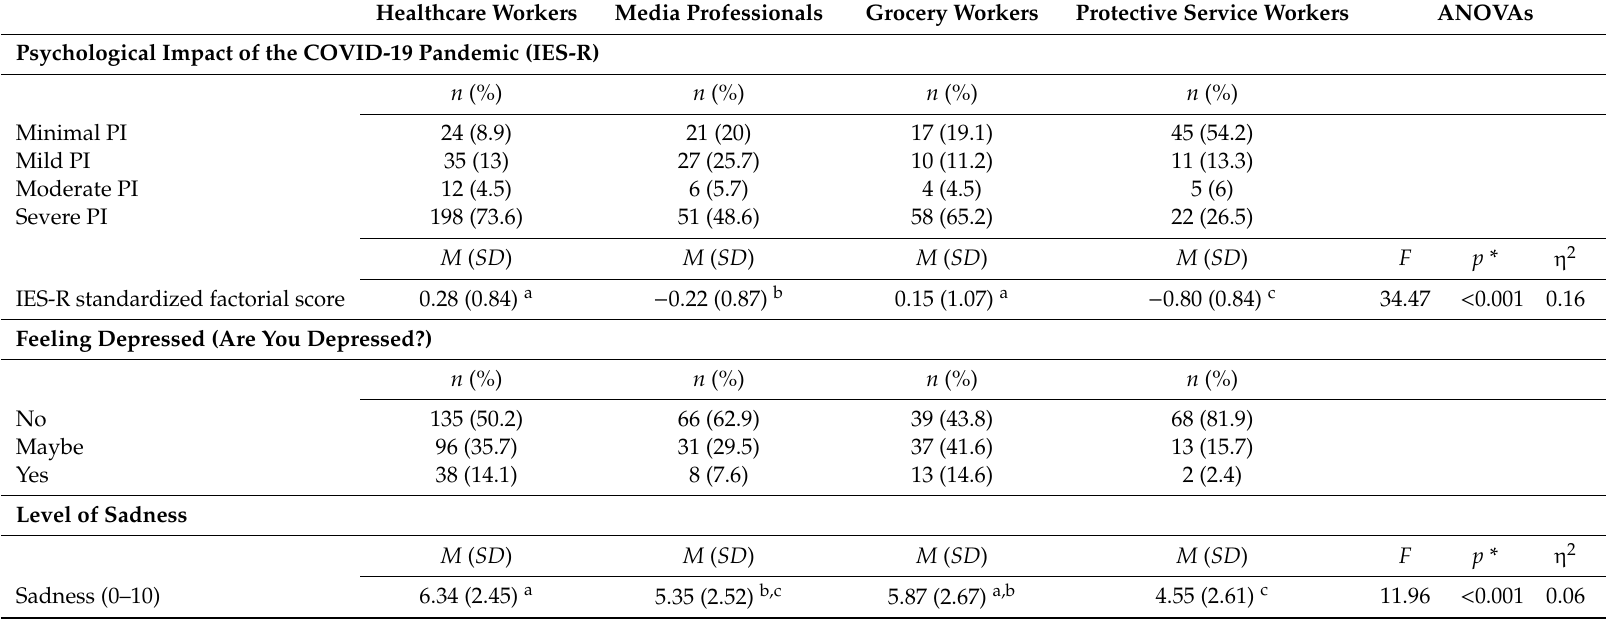
Table 2. Psychological impact (Impact of Event Scale-Revised (IES-R) standardized factorial score) of working during the COVID-19 pandemic, indicators of sadness, and ANOVAs results testing for di ff erences between groups of profession. PI: psychological impact. Healthcare Workers Media Professionals Grocery Workers Protective Service Workers ANOVAs Psychological Impact of the COVID-19 Pandemic